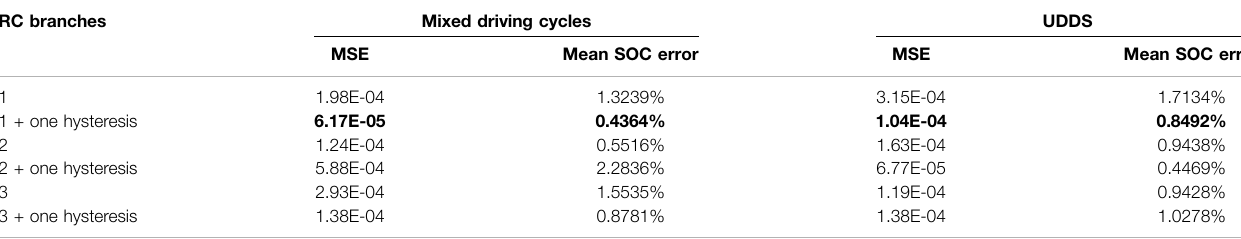
TABLE 2 | AEKF with forgetting factor λ = 0.95